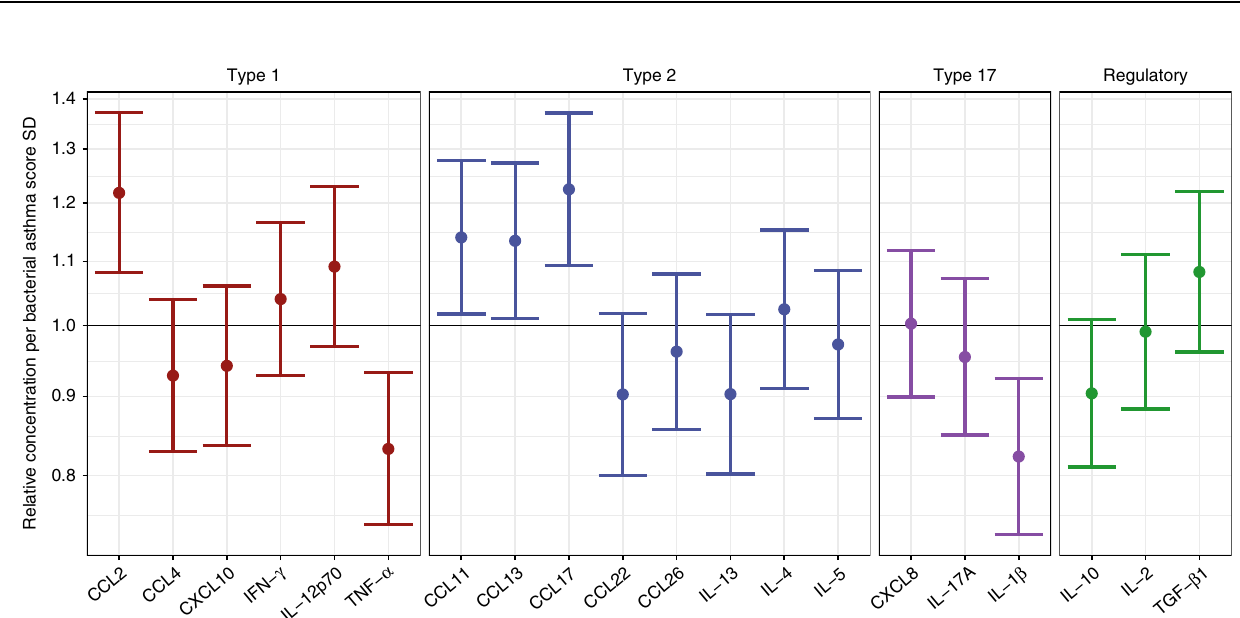
Fig. 3 Airway immune pro fi le and bacterial asthma score. Associations between the bacterial asthma score, based on Veillonella, Prevotella, Gemella, Bacilli incertae sedis, Bacillales incertae sedis, Streptococcus, and Lactobacillus, and upper airway mucosal immune mediators. Linear models show that the bacterial asthma score is associated with several immune mediators, expressed as relative concentration ratios of immune mediators per standard deviation (SD) increase in bacterial asthma score, n = 499. Error bars indicate 95% con fi dence intervals. Associations are adjusted for collinearity